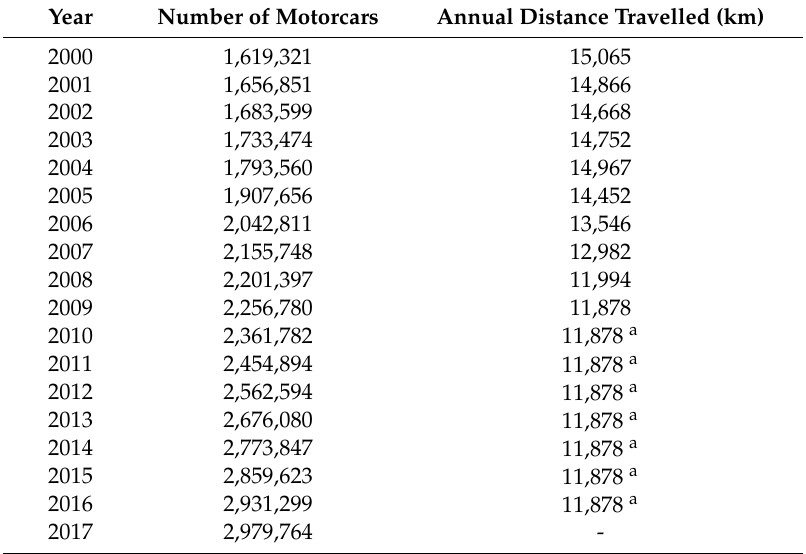
Table 3. Number of registered motorcars and annual distance travelled in Gauteng Province. Year Number of Motorcars Annual Distance Travelled